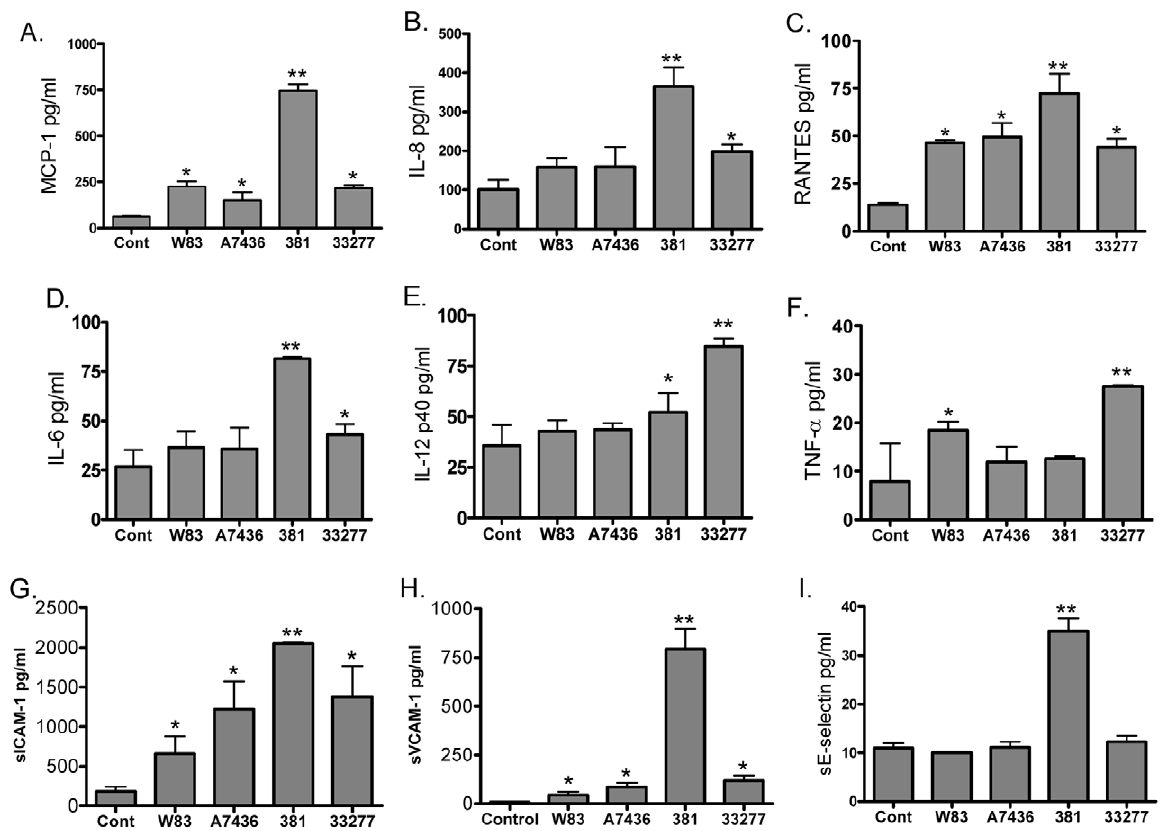
Figure 7. Endothelial response profile to P.gingivalis infection at 24 hours post-inoculation. Values represent the mean 6 SD of 3 biological replicates from 3 independent experiments. **Values were significantly different from all other groups ( P , 0.05). *Values were significantly different from control ( P , 0.05).